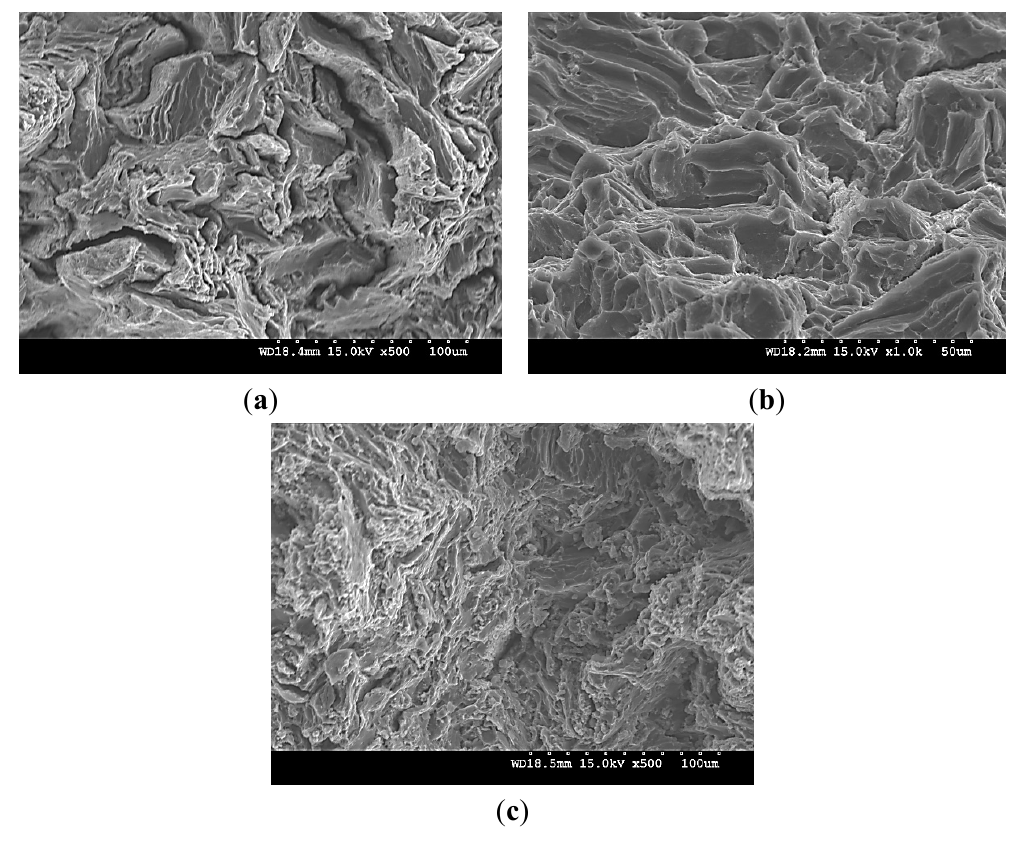
Figure 8. Fractographs after tensile loading of PM synthesized ( a ) pure Mg, ( b ) Mg 1.98 TiO 2 and ( c ) Mg 2.5 TiO 2